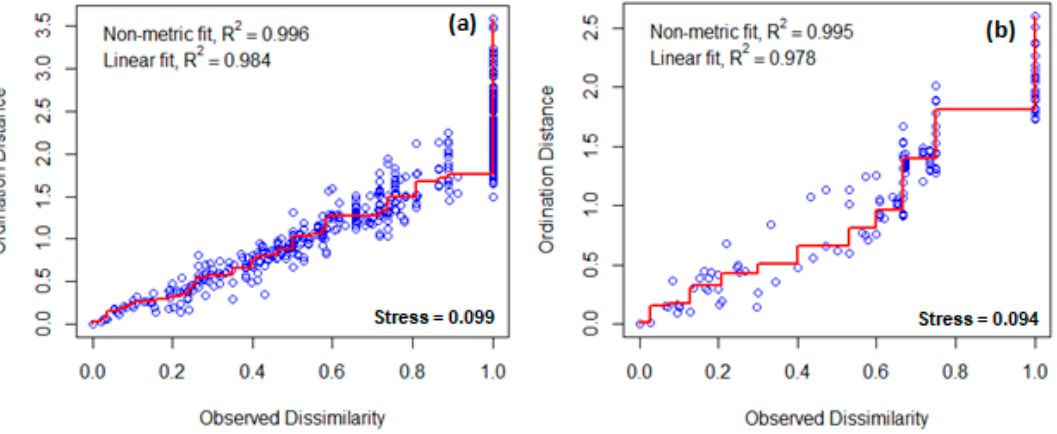
Figure 4. Stress plots (Shepard’s diagrams) showing the fit of configuration in two dimensions (k = 2) with original data patterns of counts in the rodent communities in the Chembe Bird Sanctuary landscape, Zambia, in 2018–2019 in wet ( a ) and dry ( b ) seasons, respectively. The hollow circles (points) and red lines (i.e., monotonic step lines) represent rodent counts and the model fits, respectively. The diversity of rodents varied significantly between farmlands and other habitat types in wet and dry seasons, respectively [F( 3,38 ) = 5.127, p = 0.004; F( 3,21 ) = 0.758, p = 0.035]. Comparison of Figure 5a,b depict higher mean diversity in the wet seasons than in the dry seasons, depicting similar patterns across habitat types. The diversity of rodent species varied significantly between out-CBS farmlands and counterpart in-CBS habitat types, while there were insignificant variations among in-CBS habitats (Figure